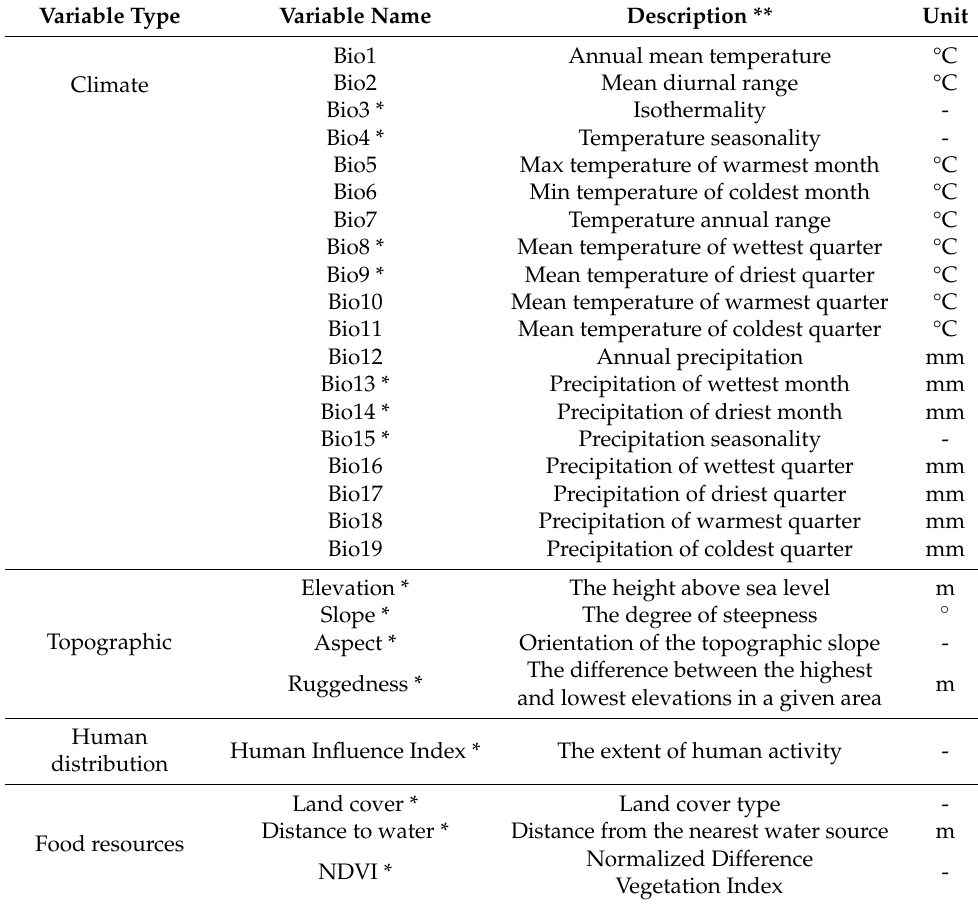
Table 1. The environmental variables used in the ensemble species distribution models (eSDMs) of Siberian ibex in Taxkorgan Nature